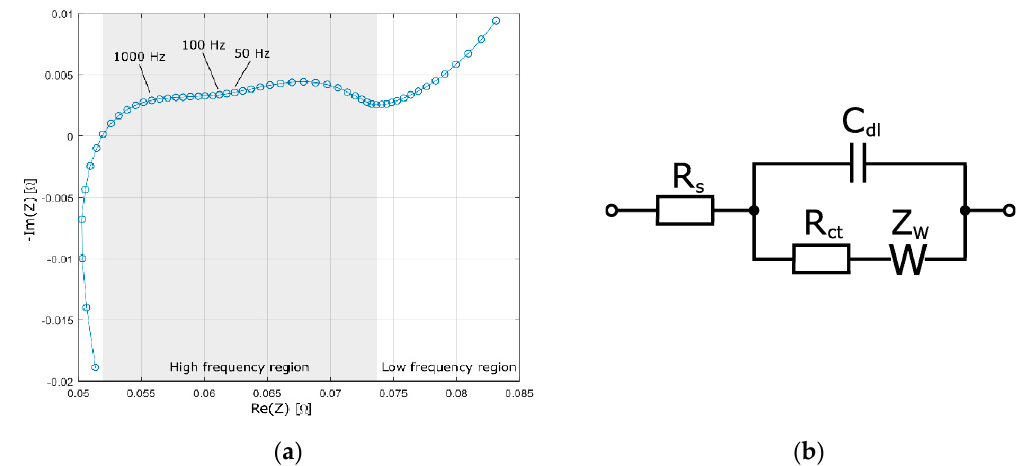
Figure 3. ( a ) Nyquist plot of tested battery, galvanostatic measurement with 100 mA amplitude, and range 10 mHz–50 kHz. Measured after tests, at room temperature, 22 ± 1 °C. ( b ) A Randles circuit, often used to simulate battery behavior. Where R s is the ohmic resistance, C dl is the electrochemical double layer capacitance, R ct is the charge transfer resistance, and Z W is the Warburg element.